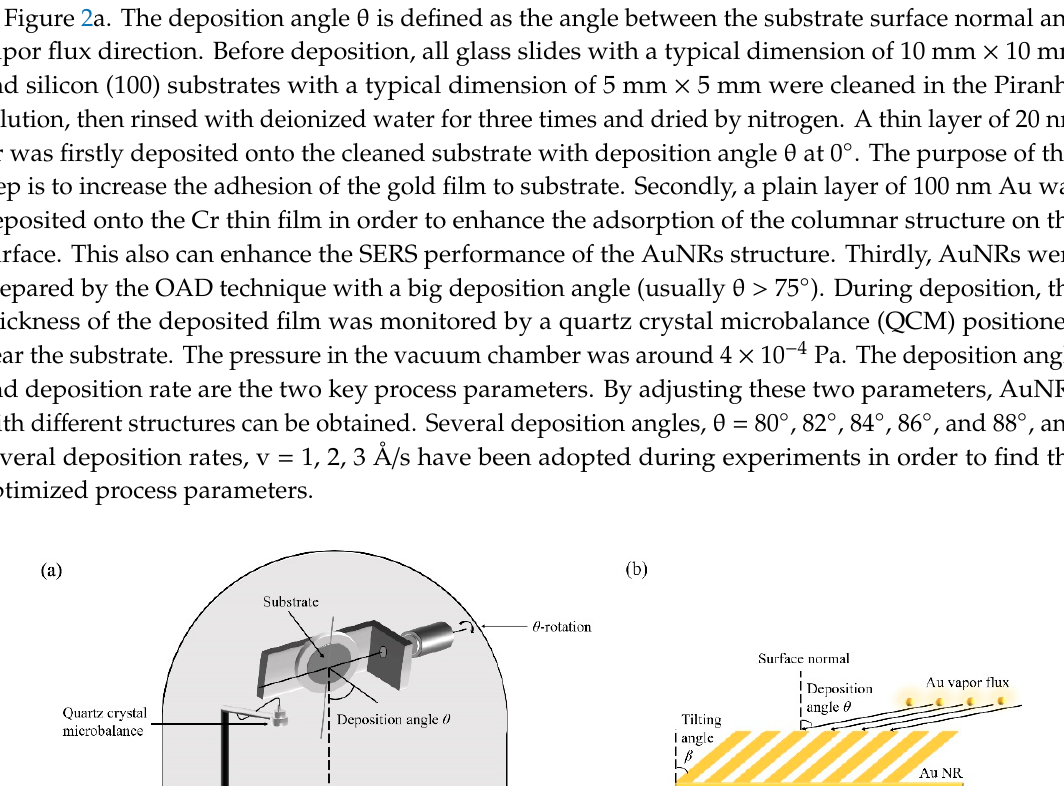
Figure 1. Models of Au nanorods (AuNRs) for finite-difference time-domain (FDTD) simulation: ( a ) XY plane, ( b ) oblique view, ( c ) XZ plane, ( d ) YZ plane.